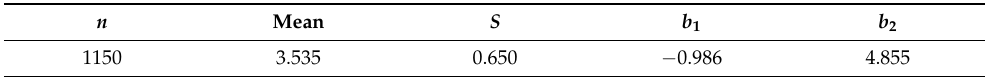
Table 4. Summary statistics for the variable